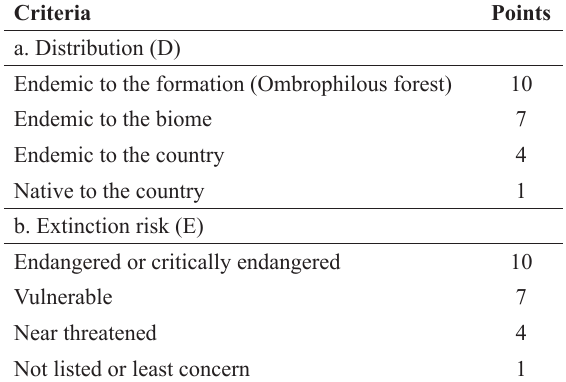
Scoring criteria employed in the classification of species according to conservation